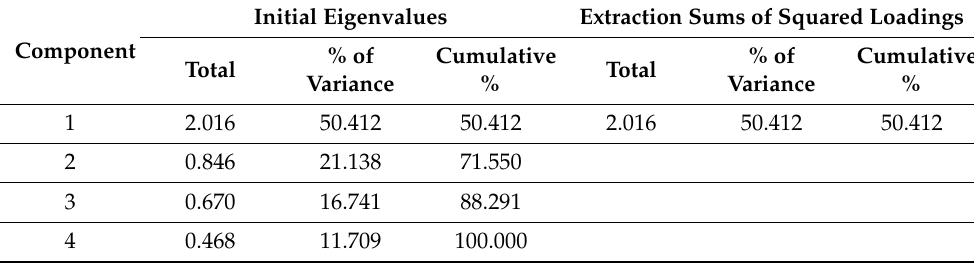
Table 7. Total variance explained (Dependent variable).